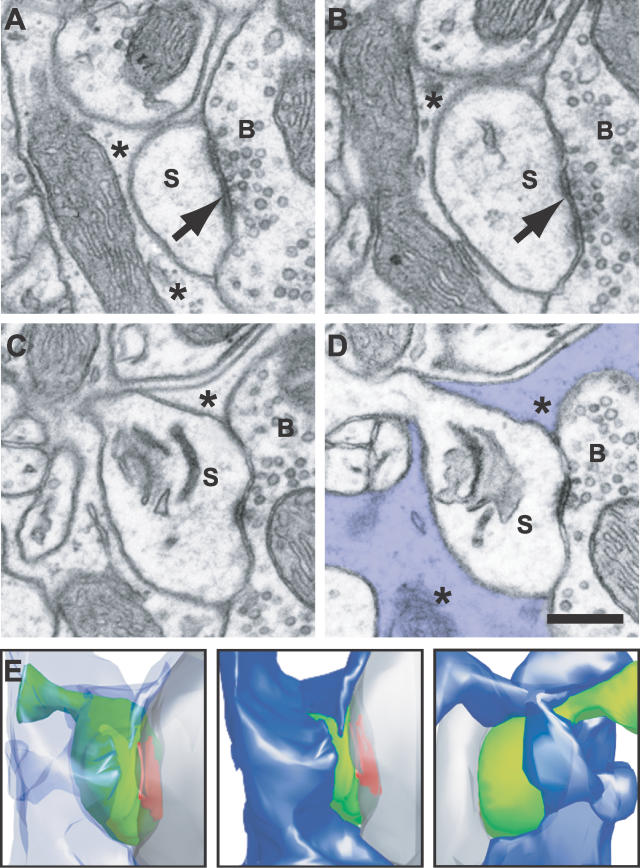
Serial EM Images, and Reconstruction, of a Dendritic Spine from a C2 Barrel Hollow(A–D) Show four micrographs from a series of 18 that were used to reconstruct the entire dendritic spine (S); making an asymmetric synaptic contact with a bouton (B) (arrow in [A] and [B]). The astrocytic element that surrounds this spine is marked with an asterisk (*) and can be seen to be closely associated with the interface between the spine head and the axonal bouton. Scale bar in (D) indicates 0.5 μm.(E) Shows the corresponding 3D reconstruction of this spine (green), bouton (grey), PSD (red), and astrocyte (blue) in three images below. The left-hand image shows the spine in the same orientation as the above micrographs, with a transparent astrocyte revealing the shape of the spine beneath; the middle image is in the same orientation, but the astrocyte is now opaque, showing the degree to which the spine is covered. The right-hand image shows the spine and covering astrocyte, viewed after a 180° rotation around the y axis.